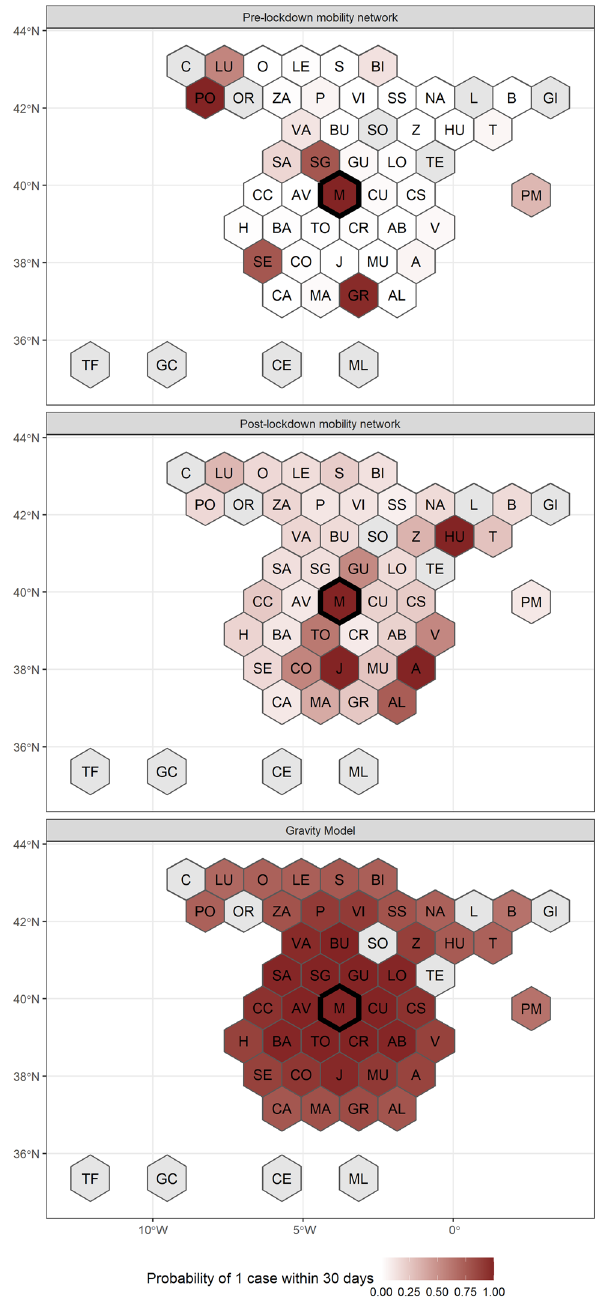
Figure 7. Simulated probability of epidemic within 30 days in provinces of Spain comparing clustered post- lockdown mobility matrices to pre-lockdown ones generated from Facebook movement data as well as a simple gravity